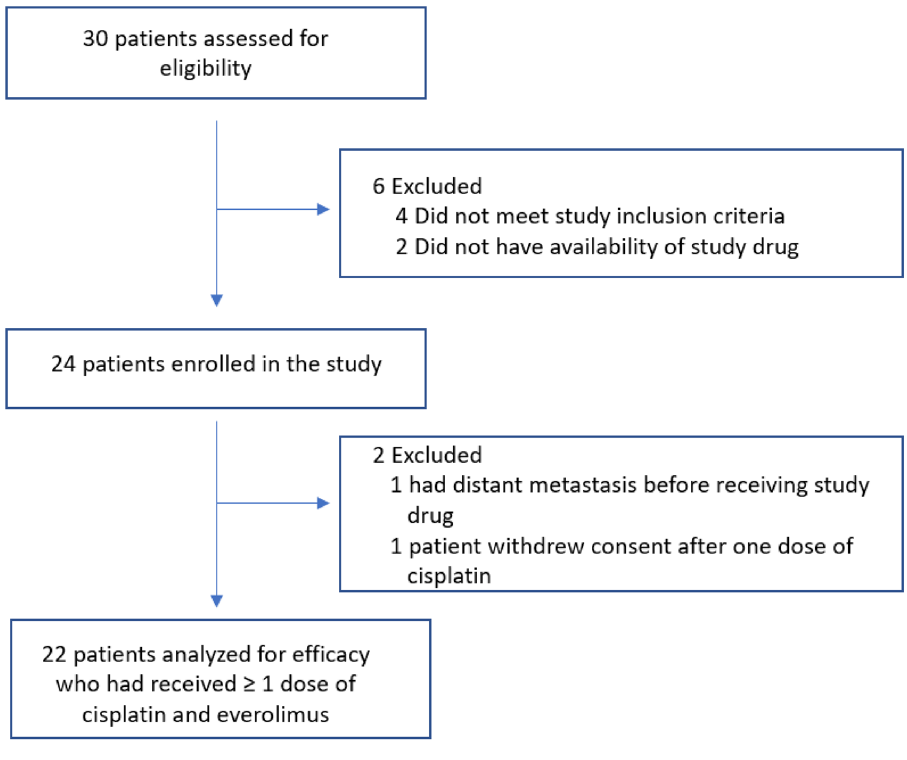
Figure 1. Consort